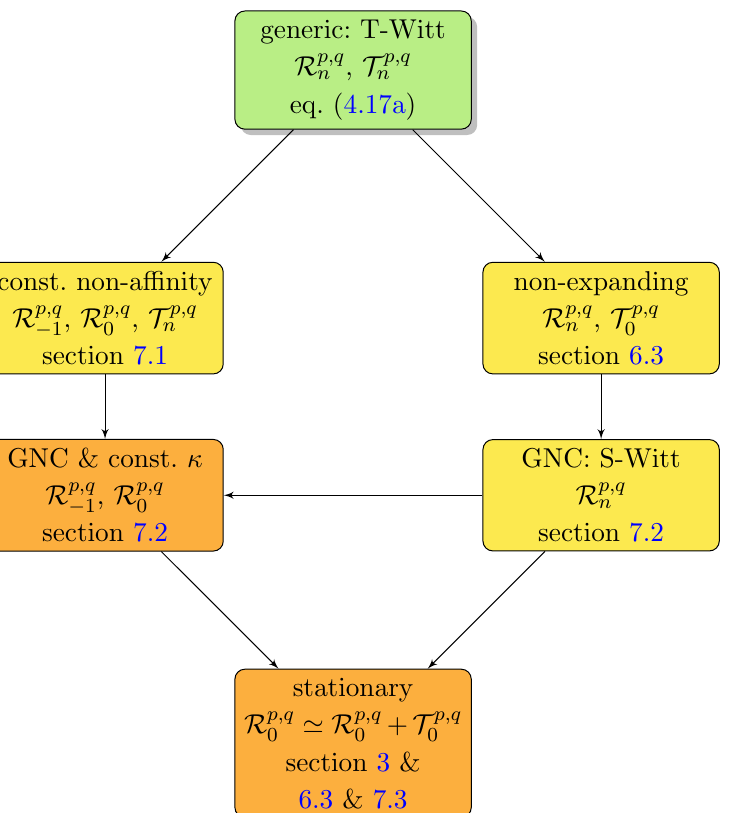
Figure 1 . Selected in(cid:12)nite subalgebras of T-Witt algebra. The null hypersurface symmetry algebra consists of superrotations and the T-Witt. Some physically motivated restrictions, such as vanishing expansion, leave intact the superrotations but reduce T-Witt to one of its subalgebras discussed in appendix B. Particularly the assumption of Gaussian null coordinates reduces T-Witt to S- Witt. Assuming additionally constant surface gravity and/or stationarity yields further reductions, recovering near horizon symmetries also found in previous